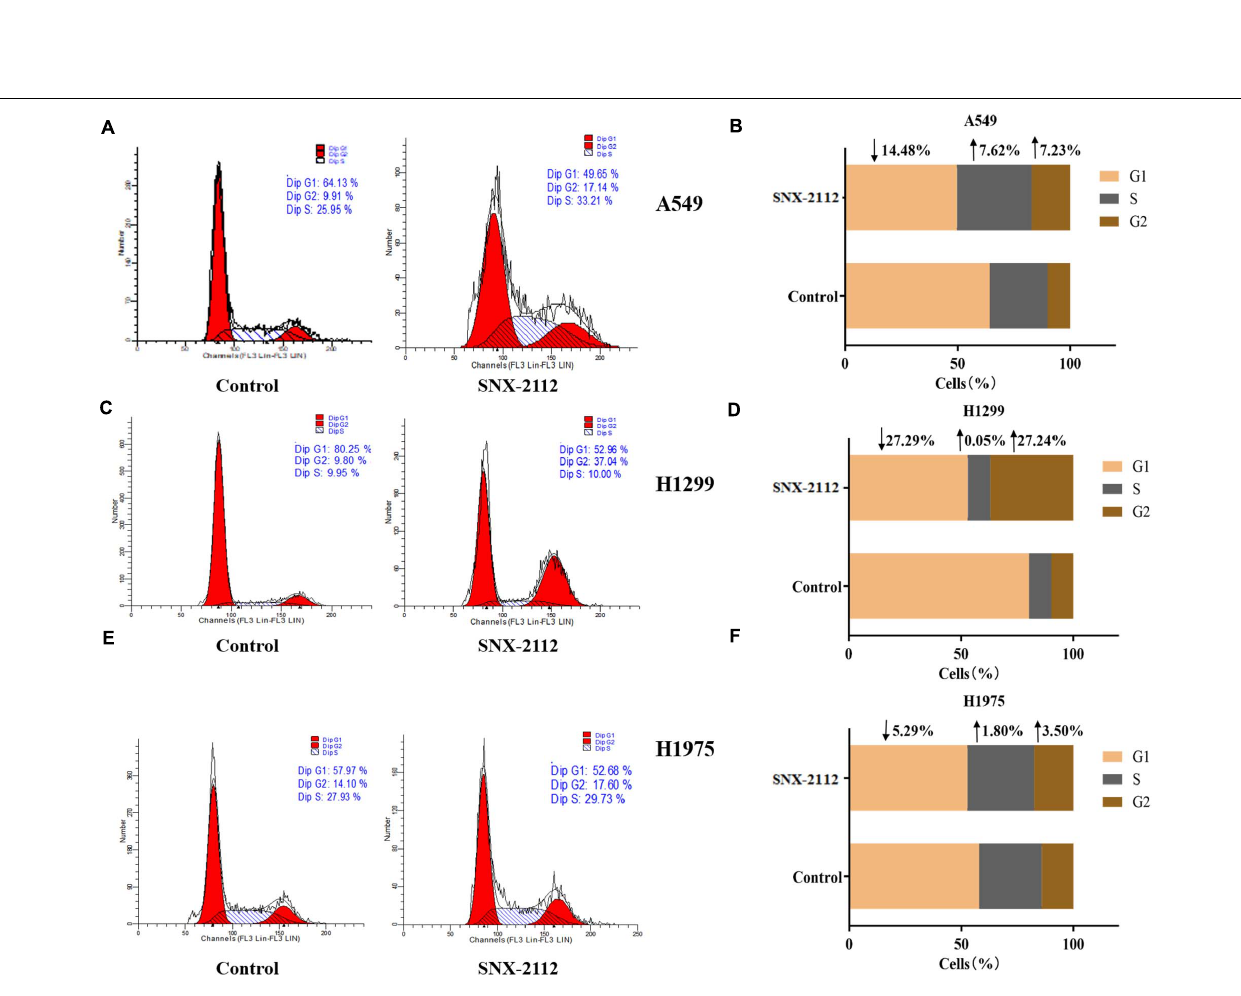
Frontiers in Cell and Developmental Biology |